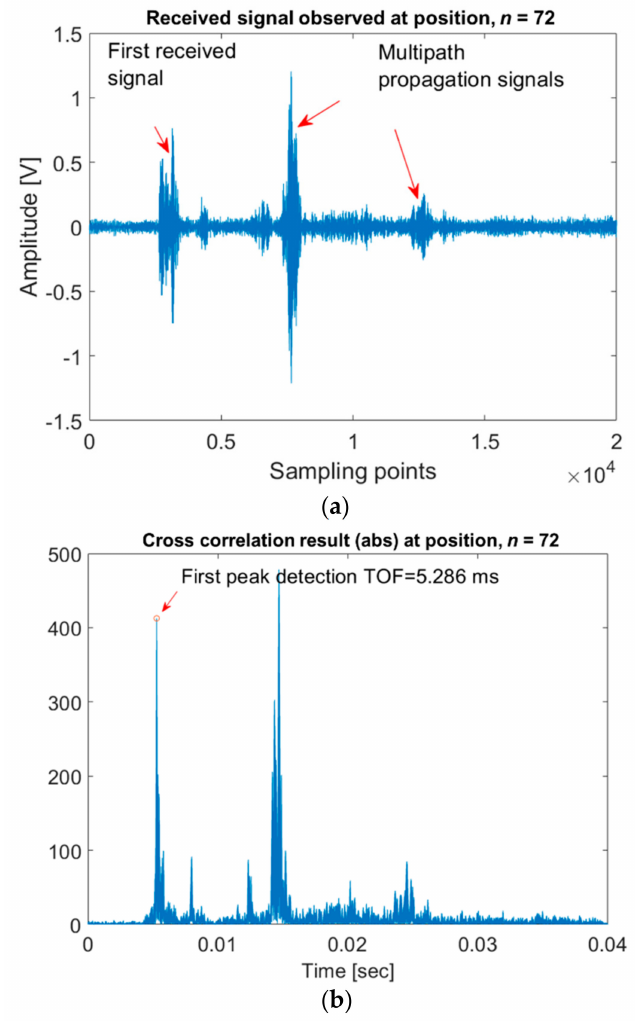
Figure 9. An example of the receiver’s signal taken at one of the target’s positions is plotted in ( a ). The corresponding cross-correlation signal is shown in ( b ). Multipath signals can be